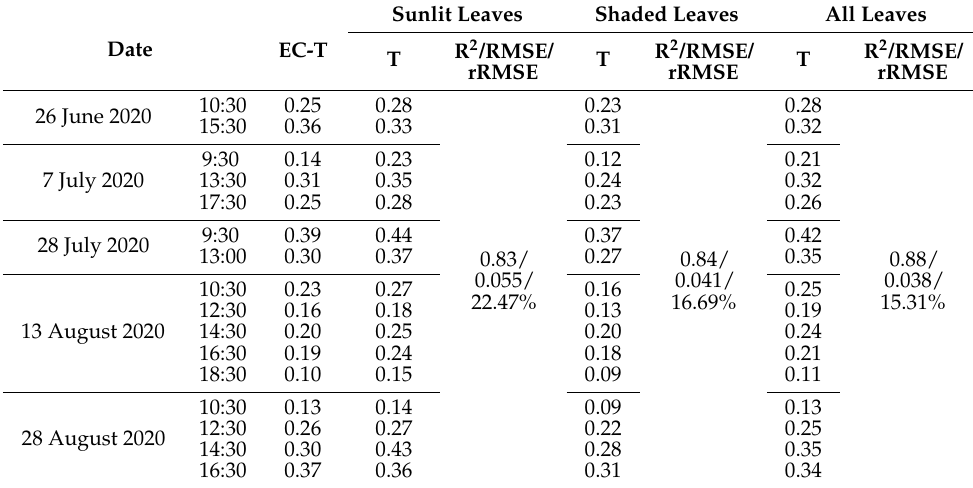
Table 2. Evaluation of transpiration rate (mm/h) accuracy of ground remote sensing inversion under different conditions.